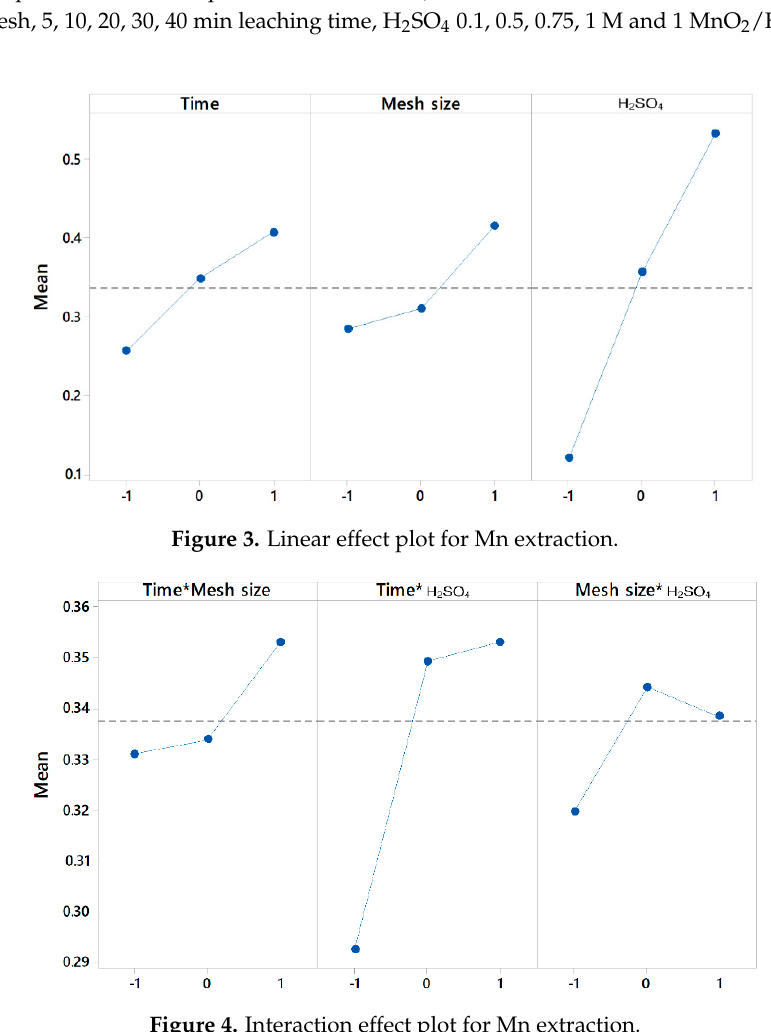
Figure 5. Curvature effect plot for Mn extraction. Equation (12) presents the Mn extraction model over the range of experimental conditions after eliminating the non-significant coefficients. %𝐸𝑥𝑡𝑟𝑎𝑐𝑡𝑖𝑜𝑛 = 0.3112 + 0.0755𝑋 (cid:2869) + 0.0651𝑋 (cid:2870) + 0.2057𝑋 (cid:2871) + 0.0303𝑋 (cid:2869) 𝑋 (cid:2871) − 0.0393𝑋 (cid:2870)(cid:2870) (12) where 𝑥 (cid:2869) , 𝑥 (cid:2870) and 𝑥 (cid:2871) are coded variables that respectively represent time, particle size and H 2 SO 4 concentration.